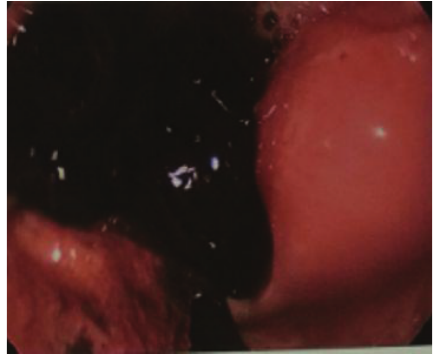
Figure 2: Hemoperitoneum noted during laparoscopy.